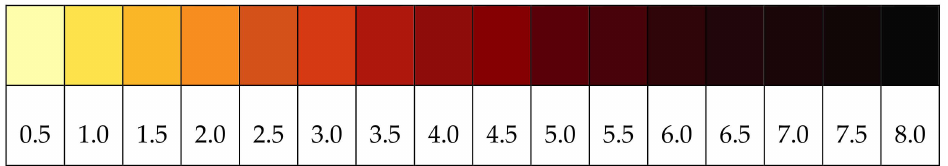
Figure 3. ASTM D 1500 Color